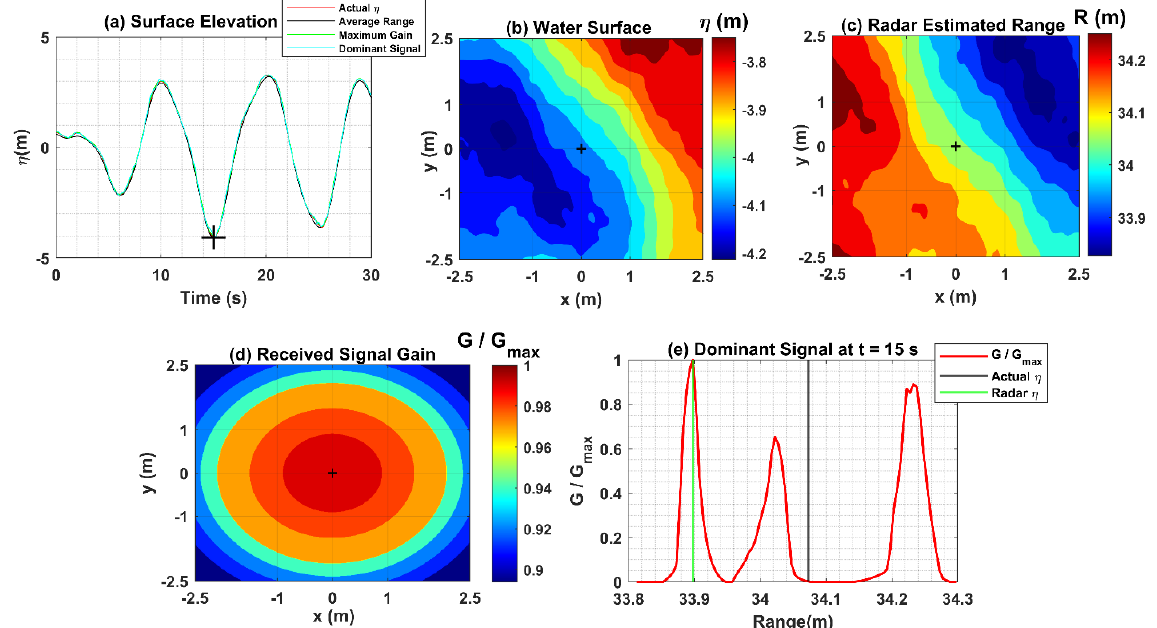
Figure 11. Radar dominant signal processing for a trough of depth − 4.1 m occurred at a time step of 15 s: ( a ) time series plots of actual surface elevations and that from the Radar signals; ( b ) water surface covered by the Radar footprint (5 m × 5 m); ( c ) Radar estimated ranges over its footprint; ( d ) normalized received signal gain over the Radar footprint; ( e ) normalized dominant signal gain as a function of range.